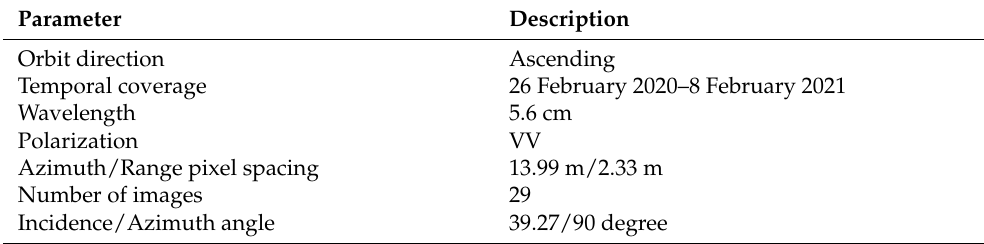
Table 1. Satellite data main